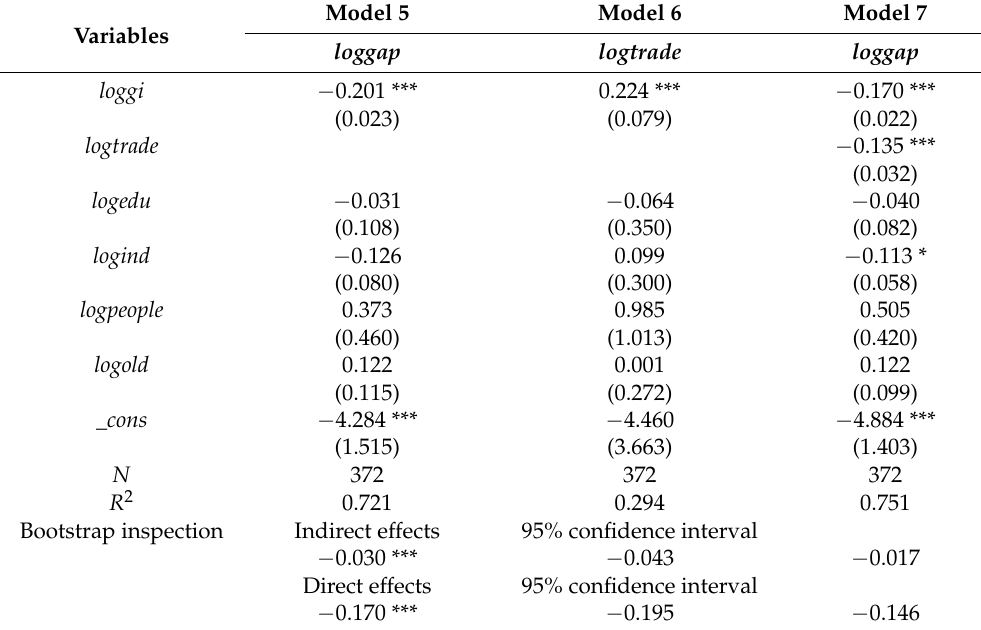
Table 9. The result of mediating effect